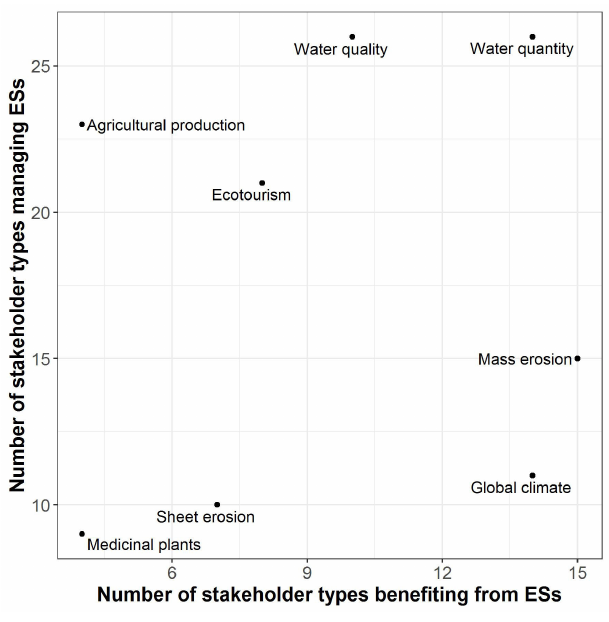
Fig. 5 . Number of stakeholder types benefiting from and managing each ecosystem service